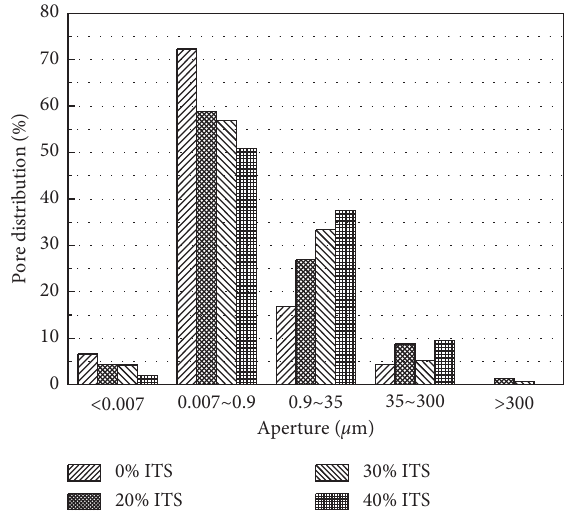
Figure 14: Relationship between the percentage of different pore distribution and